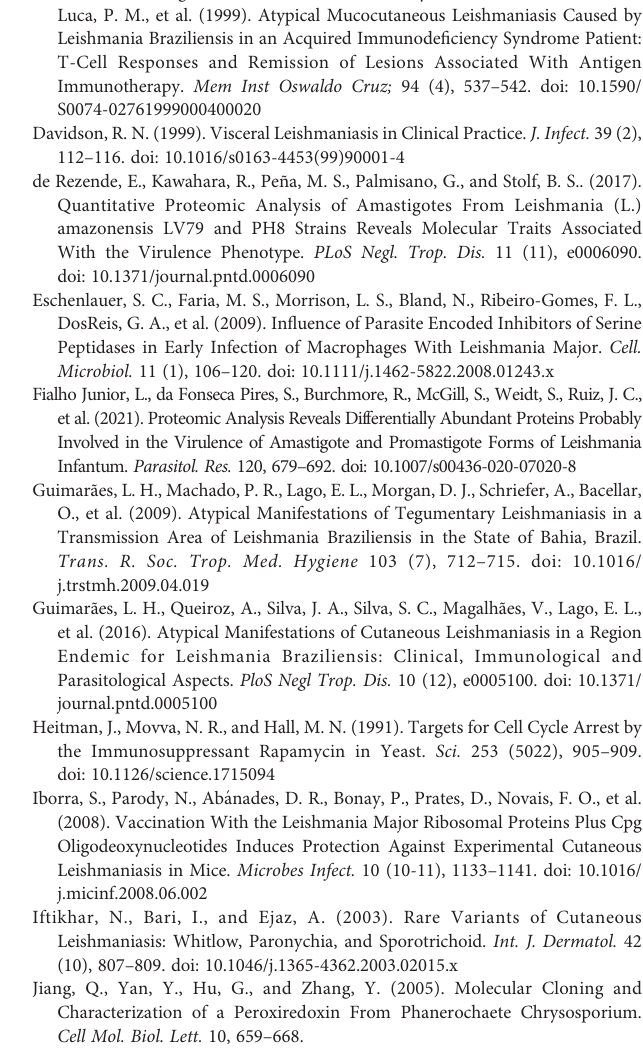
Supplementary Table S1 | All proteins identi fi ed by